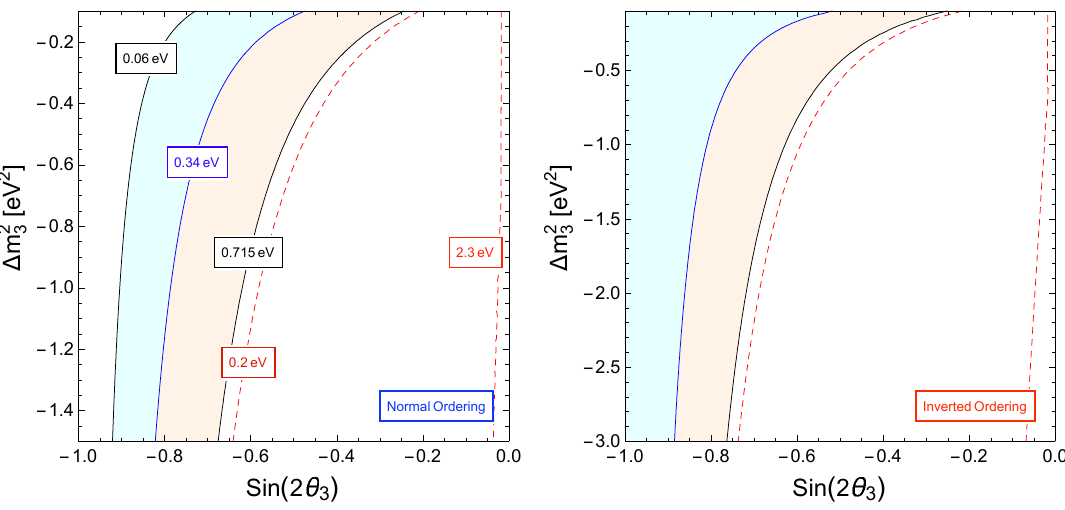
Figure 2 . Same as figure 1 except for the parameter space ( ∆ m 2